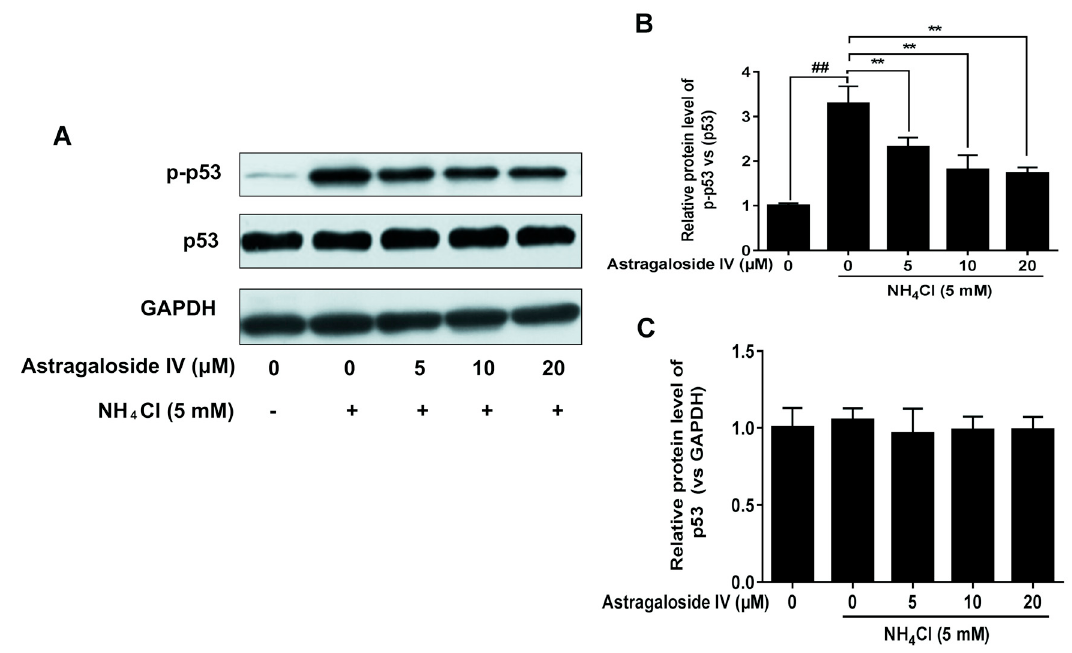
Figure 3. The protective effects of astragaloside IV on the protein levels of p-p53 and p53 induced by ammonia in MAC-T cells. The MAC-T cells were pretreated with different concentrations of astragaloside IV (0, 5, 10, and 20 μ M) for 4 h, followed by NH 4 Cl (5 mM) treatment for 24 h. The relative protein levels of p-p53 and p53 were detected by Western blotting ( A ). Relative p-p53 (vs p53) levels were analyzed by grey scanning ( B ). Relative p53 (vs GAPDH) levels were analyzed by grey scanning ( C ). GAPDH was used as an internal reference for Western blotting analysis. The data are shown as mean ± SD. n = 3. **, p < 0.01. ## indicates a significant difference from untreated cells at p < 0.01.